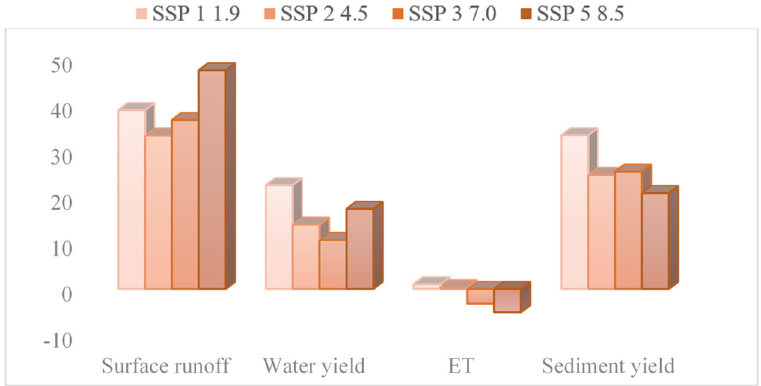
Figure 6. Combined impacts of precipitation, temperature, and atmospheric [CO 2 ] at an annual scale. (%